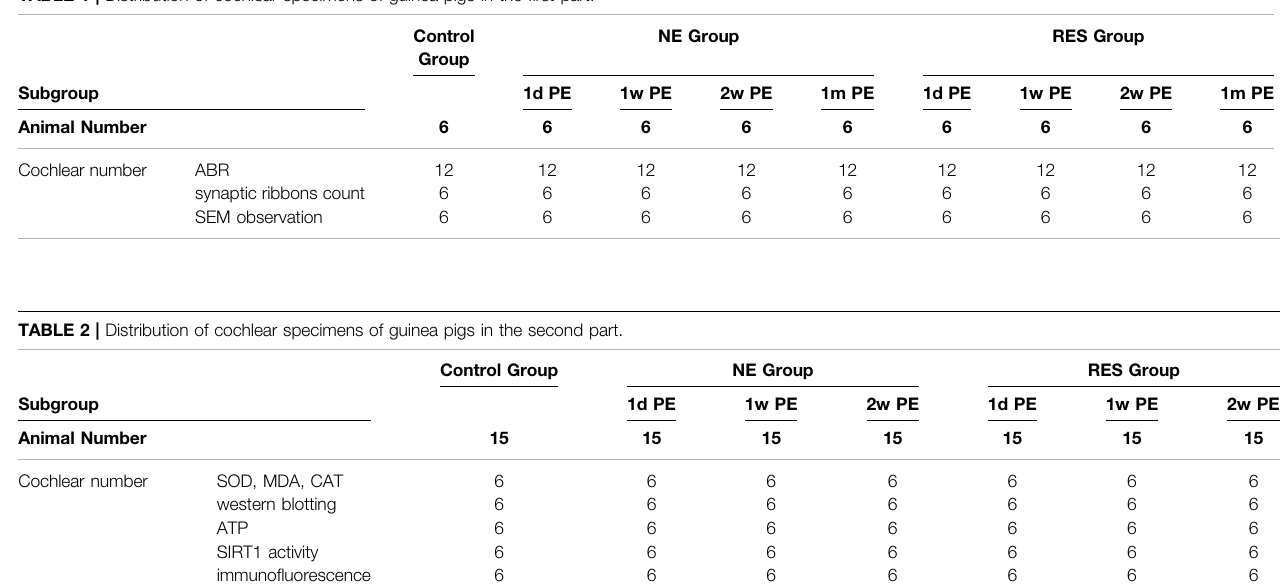
TABLE 1 | Distribution of cochlear specimens of guinea pigs in the fi rst part.